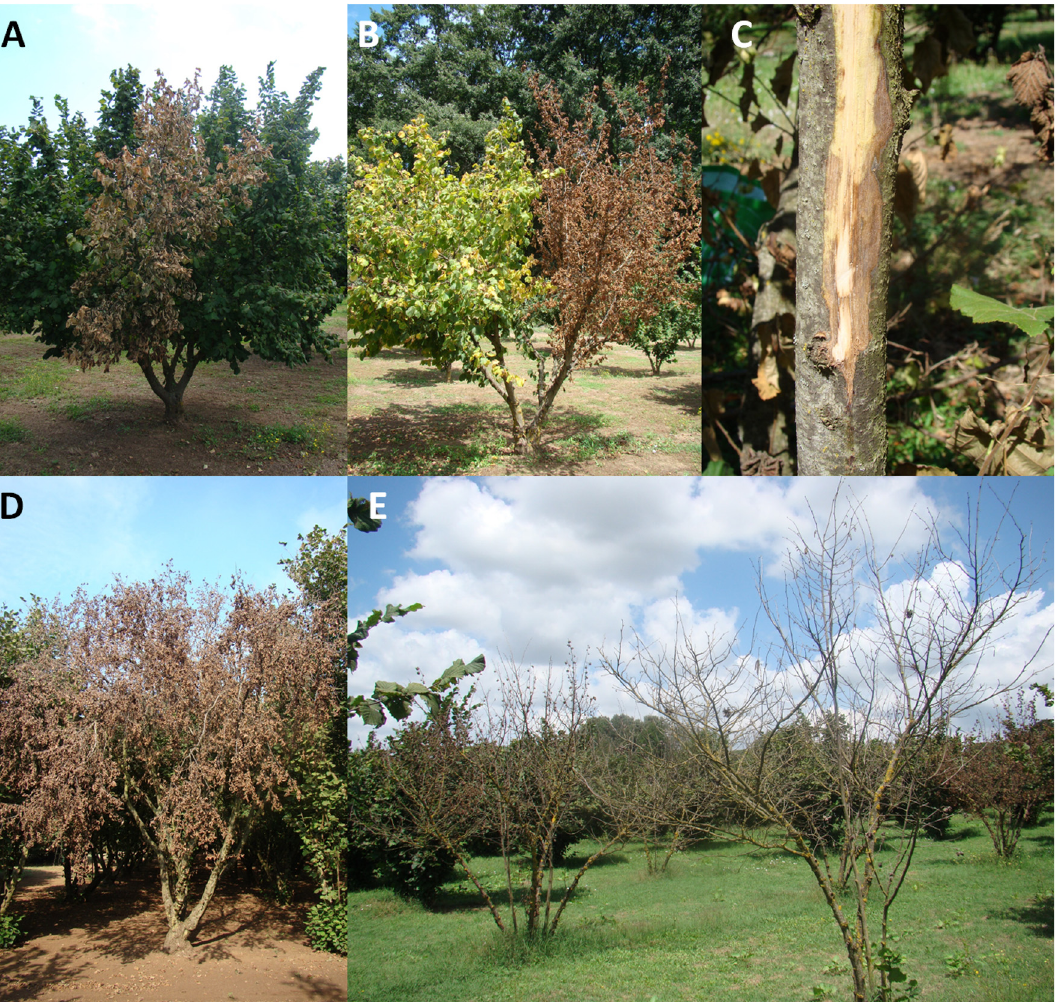
Fig 1. Characteristic hazelnut decline symptoms observed on hazelnut plants (cv. Tonda Gentile Romana). Decline began with sudden wilting of a stem (A) while the rest was still intact. Successively, decline affected the whole branch which manifested the dieback while the remaining branch manifested suffering state with pale green foliage (B). When the bark of branch bearing pale green foliage was excised, discoloration of cambium could be observed (C). During the end of vegetative phase complete plant death occurred although leaves were still attached (D). The following year, also the plants present in the proximity of the plant that showed initial decline symptoms appeared completely affected